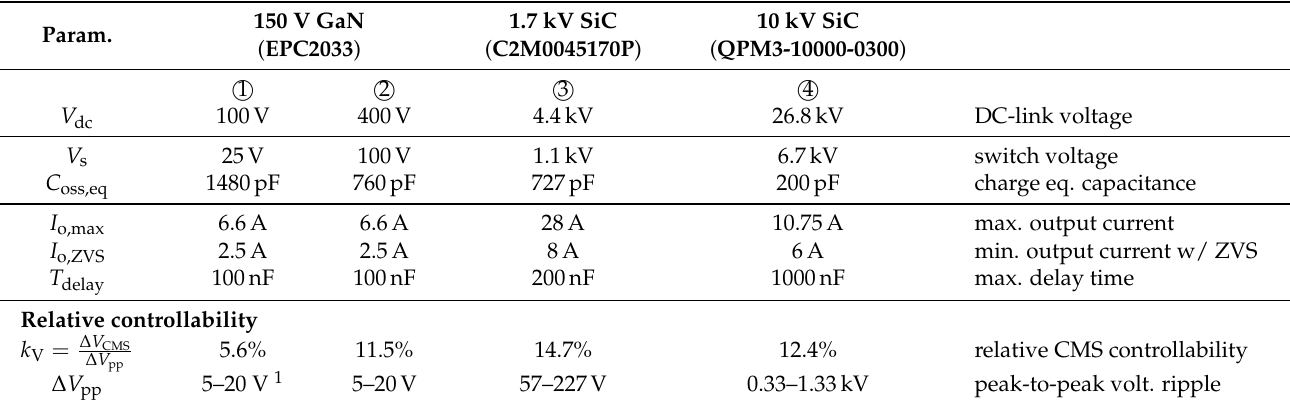
Table A1. Parameters for CMS controllability analysis for semiconductors of various voltage classes for the considered relative peak-to-peak FC voltage ripple range ∆ V pp,% = ∆ V pp / V s ∈ [ 5%,20% ] .